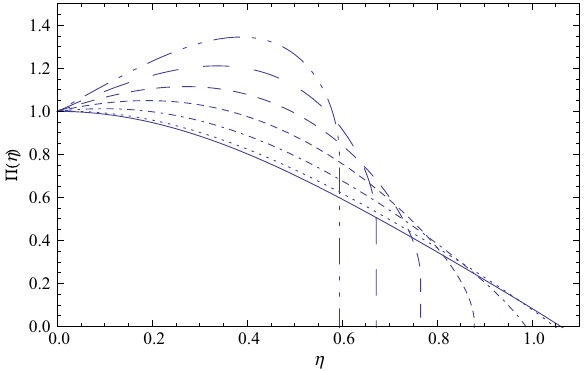
Fig. 2 Variation of the dimensionless pressure (cid:19) as a function of the dimensionless radial coordinate η for a constant density star in dRGT massive gravity theory for ψ = 0 . 06, and different values of σ : σ = − 0 . 05 (dotted curve), σ = − 0 . 25 (dashed-dotted curve), σ = − 0 . 50 (short dashed curve), σ = − 0 . 75 (dashed curve), σ = − 1 (long dashed curve),and σ = − 1 . 25(longdashed-doubledottedcurve).Thestandard general relativistic case also corresponds to ψ = σ = 0 (solid curve)